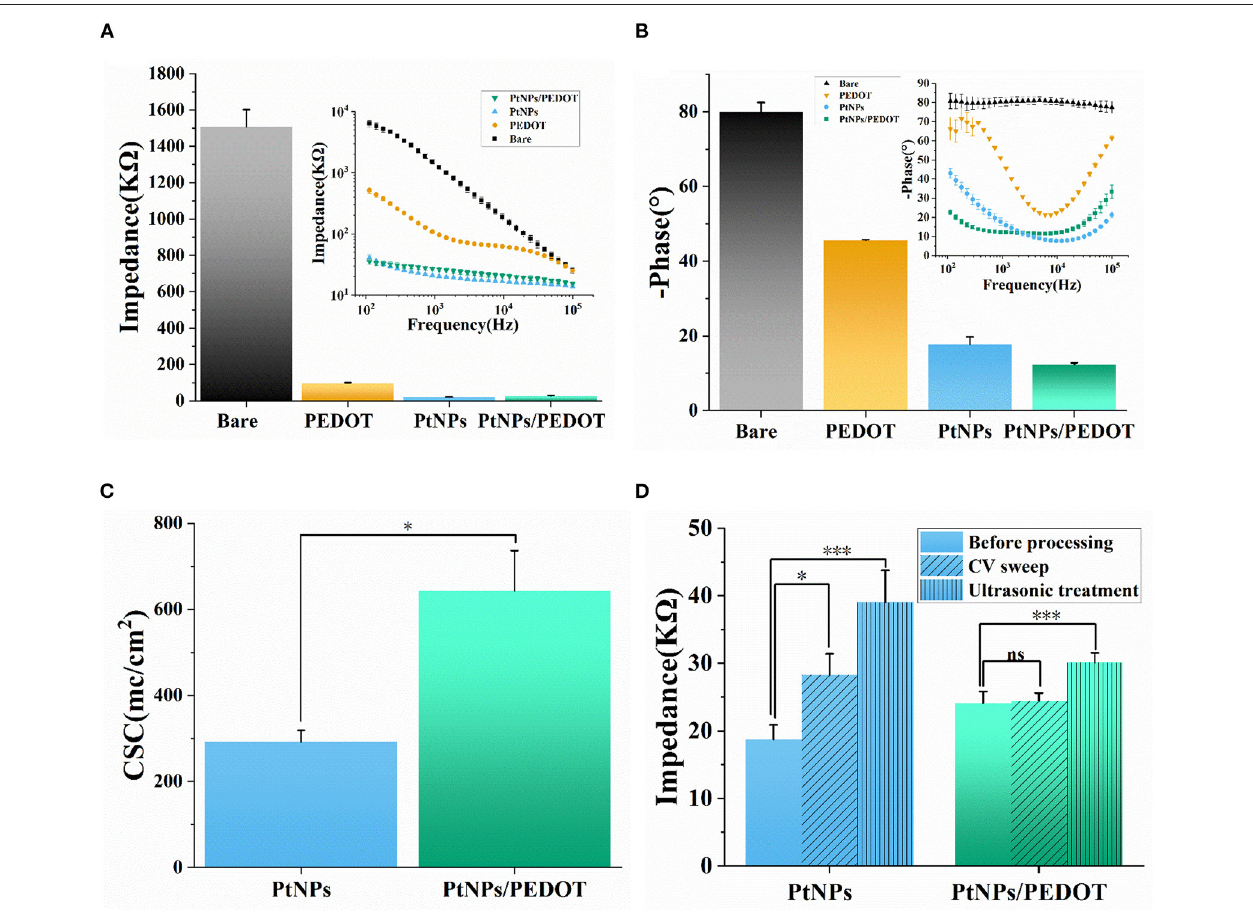
FIGURE 4 | Electrode characterization and stability test. (A,B) Average impedance and phase delay of the different modified electrodes at 1kHz ( n = 5 recording sites, the illustration shows the phase delay and impedance at 100 Hz − 100kHz scanning frequency). (C) CSC of PtNPs/PEDOT:PSS- and PtNPs-modified electrode ( n = 4 recording sites). (D) Impedance (1kHz) of PtNPs and PtNPs/PEDOT:PSS electrodes after CV scanning and ultrasonic vibration ( n = 4 recording sites). Data are means ± SE. One-way ANOVA for statistical analysis in (A–C) , and one-way repeated measures ANOVA for statistical analysis in (D) . See Supplementary Material Tables 1, 4 for statistical analysis in (A) and (B) . * p < 0.05; *** p < 0.001; ns, p >